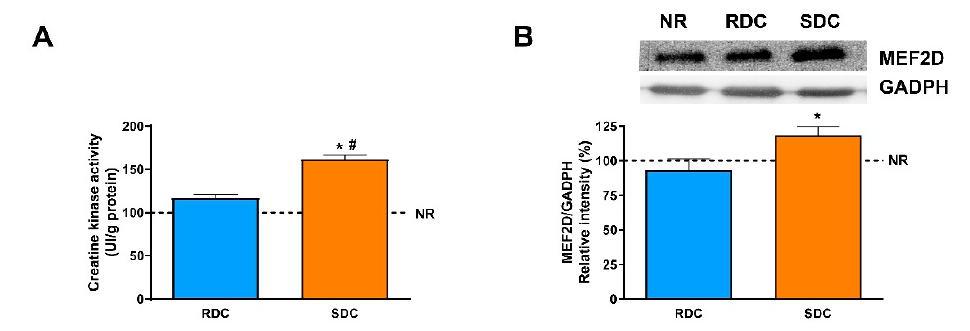
Figure 5. Markers of muscle performance. ( A ). Creatine kinase activity and ( B ) myocyte enhancer factor 2D (MEF2D) expression as markers of muscle performance and di ff erentiation. NR group, not restricted; RDC group, re-feeding with rapid digestible CHO diet; SDC group, re-feeding with slow digestible CHO diet. * Significant di ff erence with NR group, p < 0.05. # Significant di ff erence with RDC group, p < 0.05.